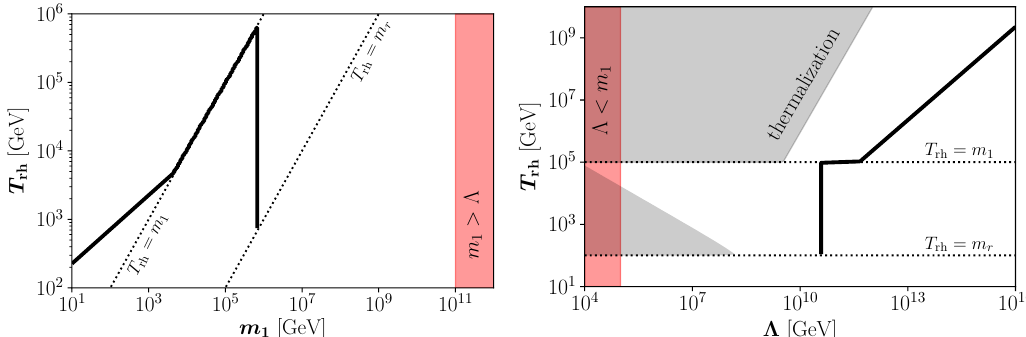
Figure 4 . Sequential freeze-in via inverse decays: Reheating temperature required to reproduce the experimentally observed DM abundance, (cid:10) (cid:31) h 2 , for m (cid:31) = 1 MeV. Left panel: T rh as a function of m 1 for (cid:3) = 10 11 GeV; right panel: T rh as a function of (cid:3) for m 1 = 10 5 GeV. In both panels, the radion mass is m r = m 1 = 10 3 . The gray-shaded areas are the regions where chemical equilibrium with the SM is reached (and freeze-in does not occur), whereas the red-shaded areas are the regions where m 1 > (cid:3) and the EFT approach breaks down. Eventually, the two black-dotted lines give